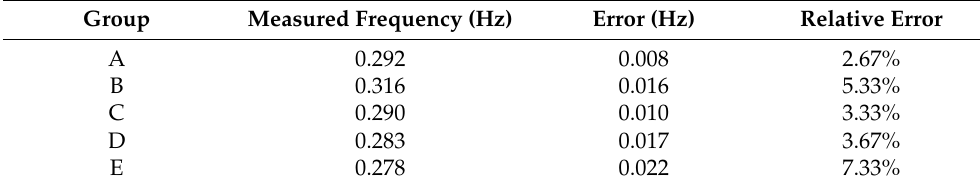
Table 3. Experimental platform frequency test